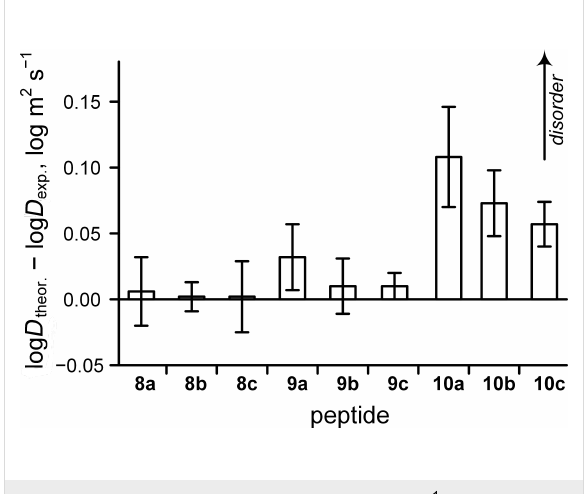
Figure 6: Conformational analysis of the peptides by 1 H DOSY NMR (D 2 O, 298 K). The theoretical values were calculated according to Equation 5 assuming deuterium oxide viscosity and 298 K.